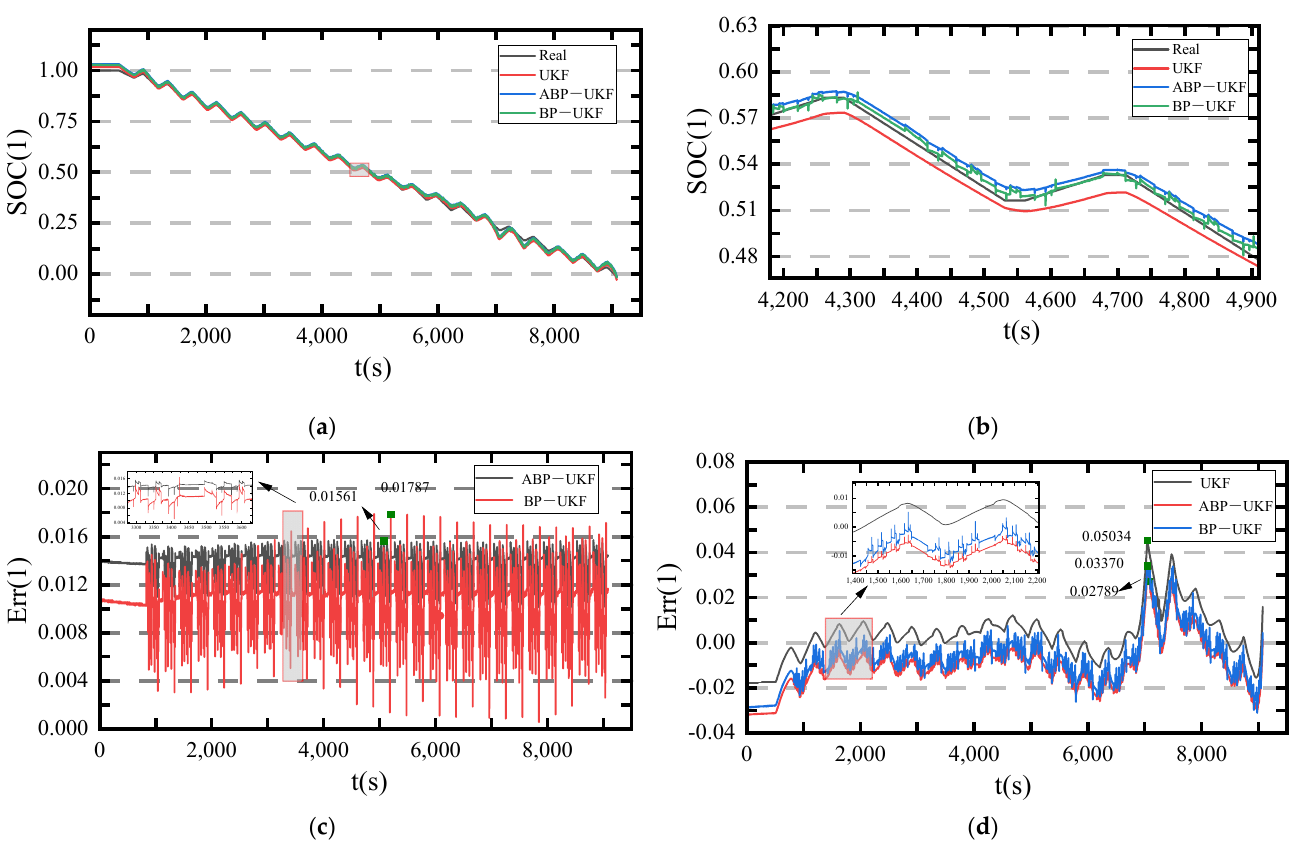
Figure 10. SOC estimation and error comparison under DST. ( a ) Estimation results of the SOC under the DST working conditions. ( b ) Enlarged view of the estimation results of the SOC under the DST working conditions. ( c ) Correction value based on the UKF algorithm. ( d ) Error of the SOC under the DST working conditions. Table 4. Criteria for the SOC estimation results under the DST working